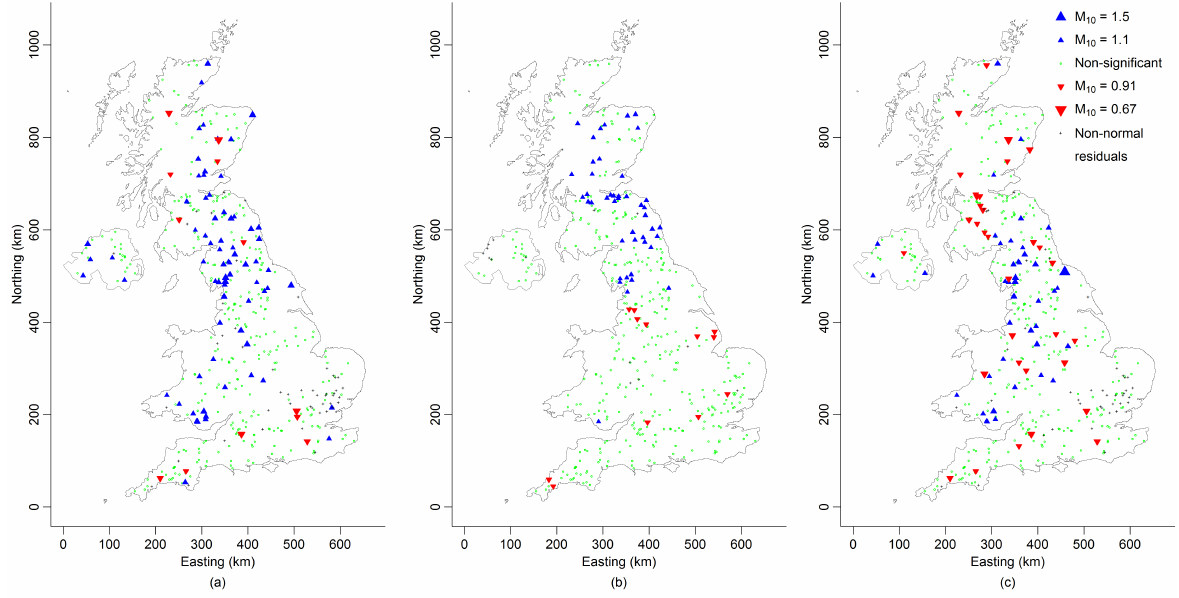
Fig. 8. Estimated decadal magnification factor M 10 for: (a) peak flow maxima with time as the only explanatory variable (model (a)), (b) daily rainfall maxima with time as the only explanatory variable, and (c) peak flow maxima with time and the 99th percentile of daily rainfall as explanatory variables – annual maxima series.